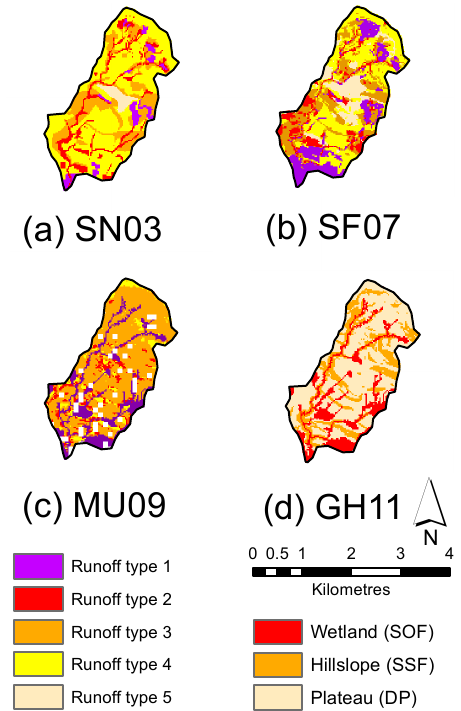
Figure 3. DRP maps for the Meilen catchment: (a) reference map according to Scherrer and Naef (2003) and automatically derived map according to (b) Schmocker-Fackel et al. (2007), (c) Müller et al. (2009), and (d) Gharari et al.